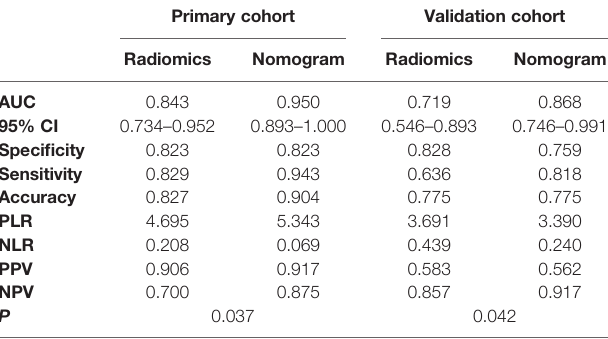
TABLE 4 | ROC analysis of the prediction models in both